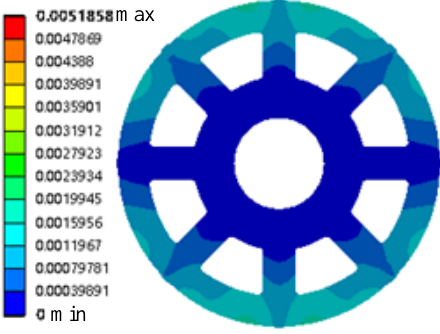
Figure 17. Strain distribution diagram of the rotor shutdown condition.